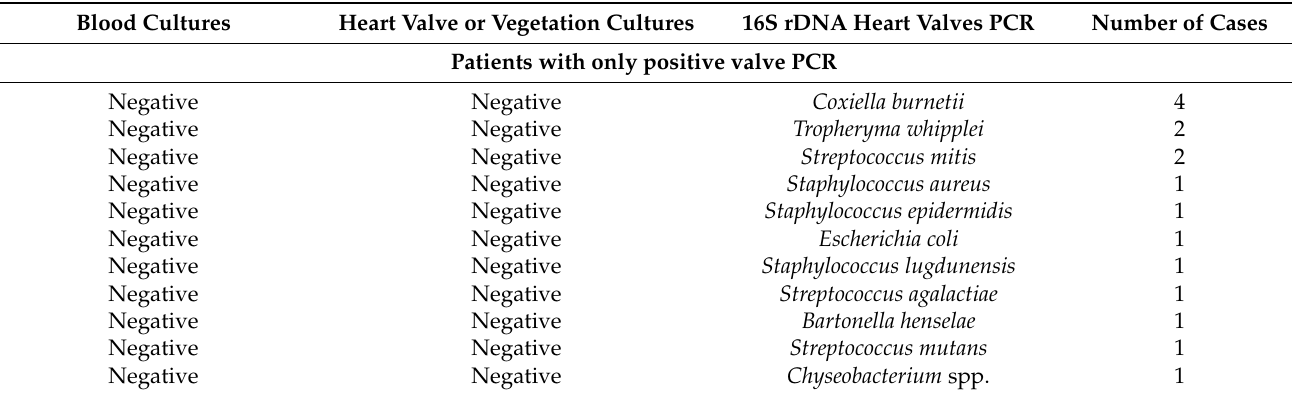
Table 4. Diagnostic benefit of 16S rDNA PCR for patients with infective endocarditis. Blood